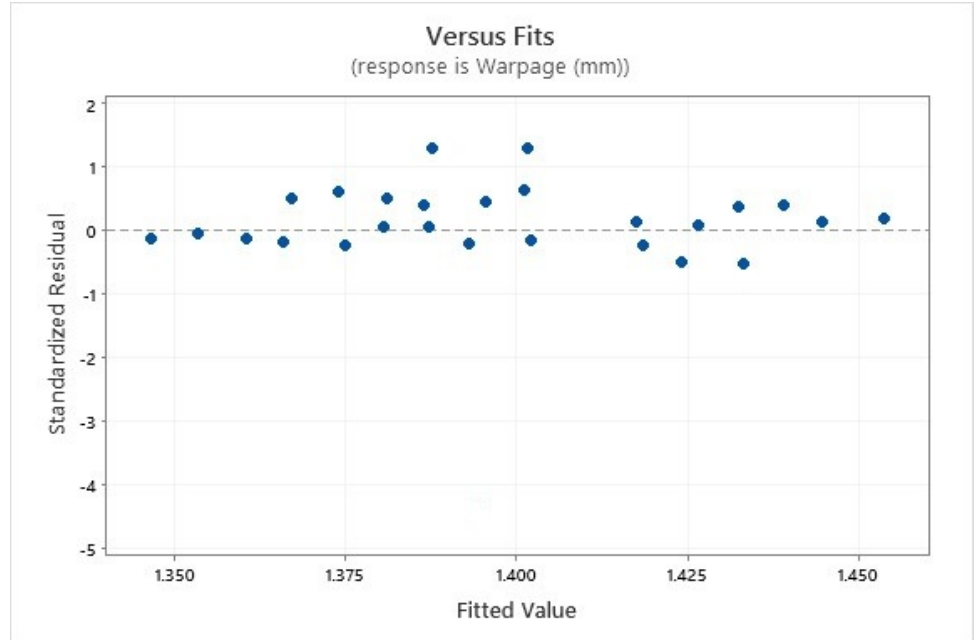
Figure 9. Standard Residual Plot for Numerical Simulations.